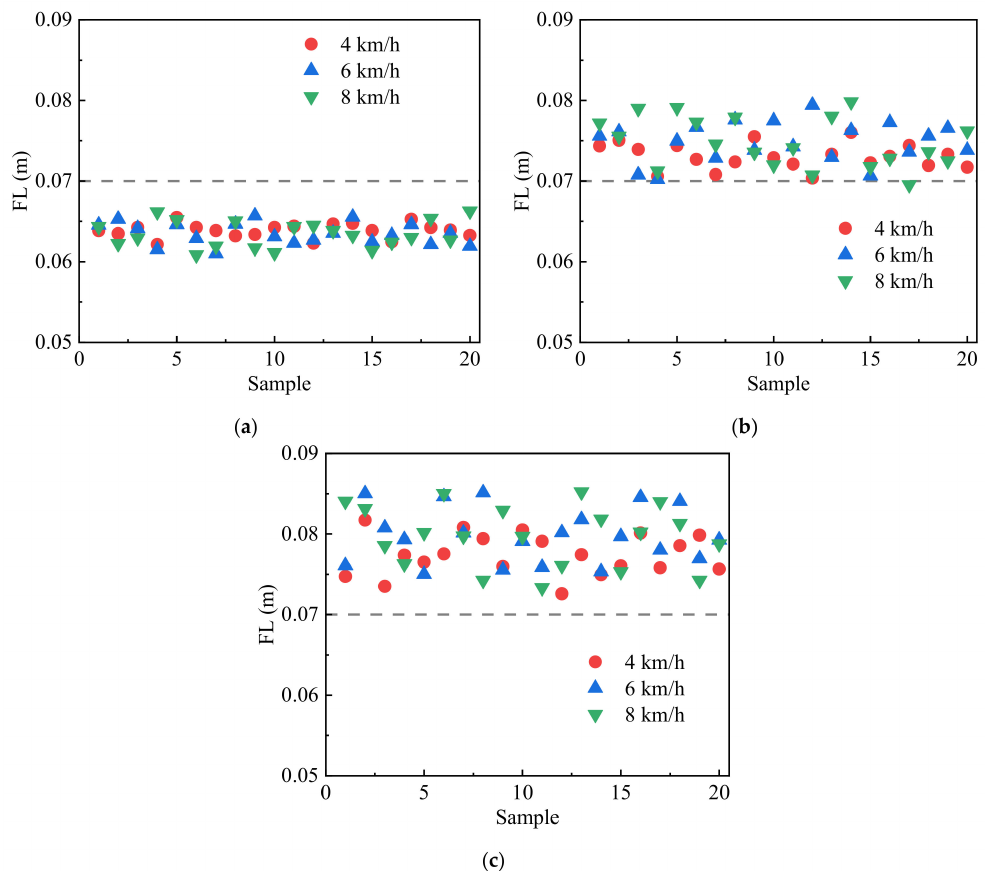
Figure 12. The distribution uniformity of the length of the liquid starter fertilizer (FL) at different pressures of ( a ) 0.1, ( b ) 0.2, and ( c ) 0.3 MPa.